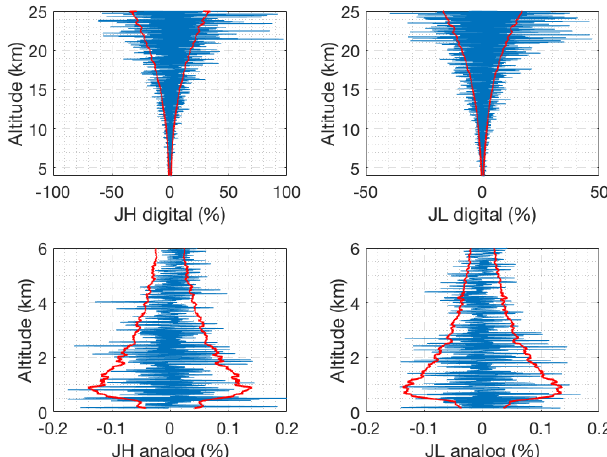
Figure 2. Difference between the forward model and clear night- time RALMO measurements on 9 September 2011 for the four sig- nals (blue). The red curves show the standard deviation of the mea- surements